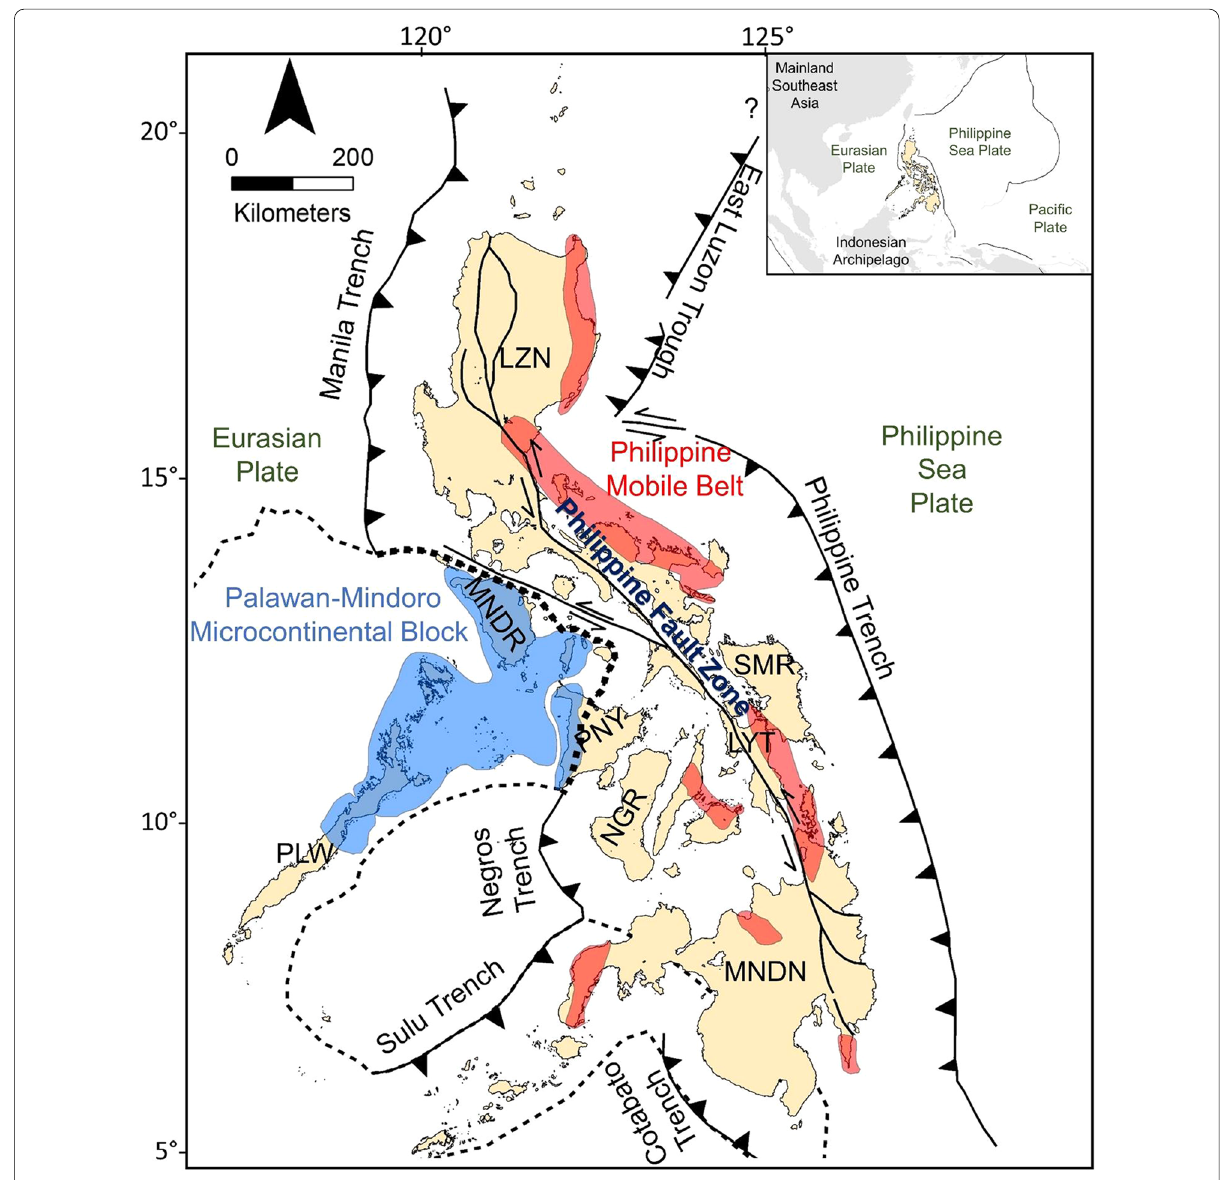
Fig. 1 General tectonic map of the Philippine island arc system (modified from Rangin 1991; Yumul et al. 2008a, b). The continental Palawan-Mindoro Microcontinental Block and island arc Philippine Mobile Belt (PMB) characterize the Philippine Archipelago. The mentioned islands are represented by green labels: LZN Luzon, MNDR Mindoro, PLW Palawan, PNY Panay, NGR Negros, SMR Samar, LYT Leyte, = = = = = = = MNDN Mindanao. Red areas represent Cretaceous (island arc) metamorphic zones, while blue areas correspond to pre-Cretaceous (continental) = metamorphic regions (modified from MGB 2010). The inset map shows the location of the Philippines relative to Southeast Asia. The traces of plate boundaries are from USGS (2019) (https:// www. usgs. gov/ media/ files/ plate- bound aries- kmz-